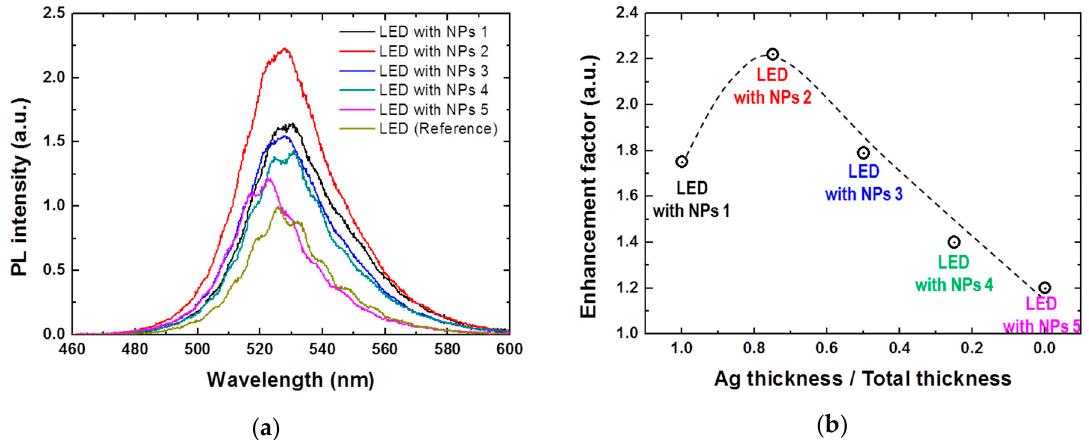
Figure 4. ( a ) PL spectra of the LED without NPs (reference), the LED with NPs 1, the LED with NPs 2, the LED with NPs 3, the LED with NPs 4, and the LED with NPs 5. ( b ) The enhancement factors of the LED with NPs 1, the LED with NPs 2, the LED with NPs 3, the LED with NPs 4, and the LED with NPs 5.